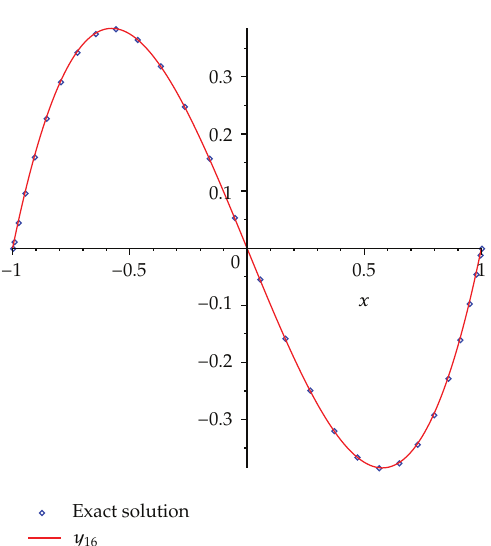
Figure 4: Comparison of the numerical solution with the 16th-order SHAM solution for h (cid:8) − 0 . 4.